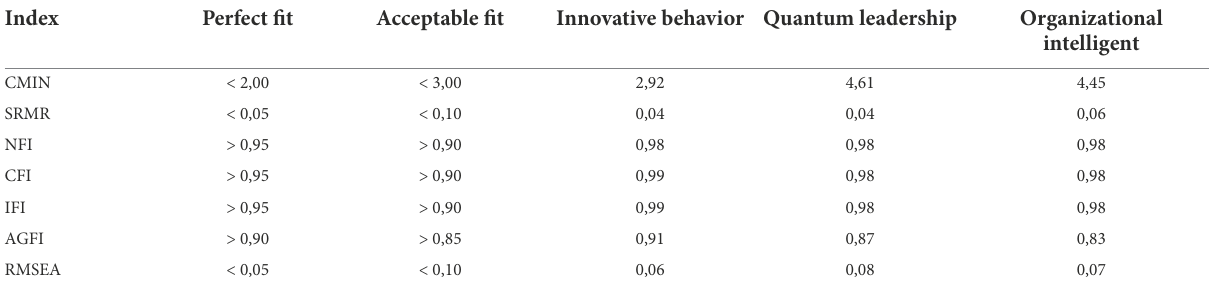
TABLE 2 DFA model fit.